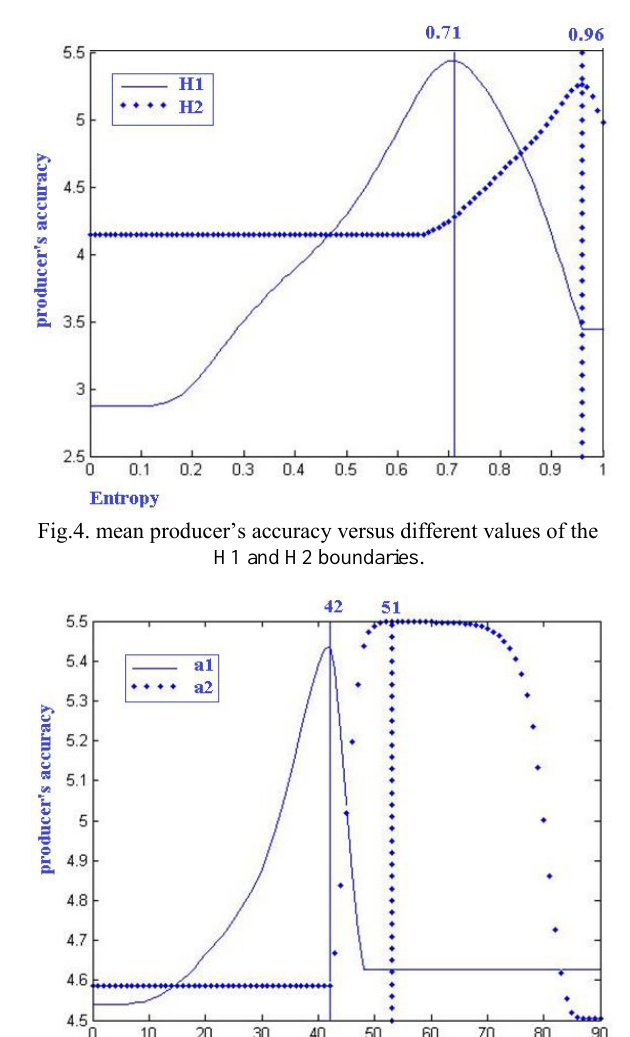
Fig.5. mean producer’s accuracy versus different values of the a1 and a2 boundaries.